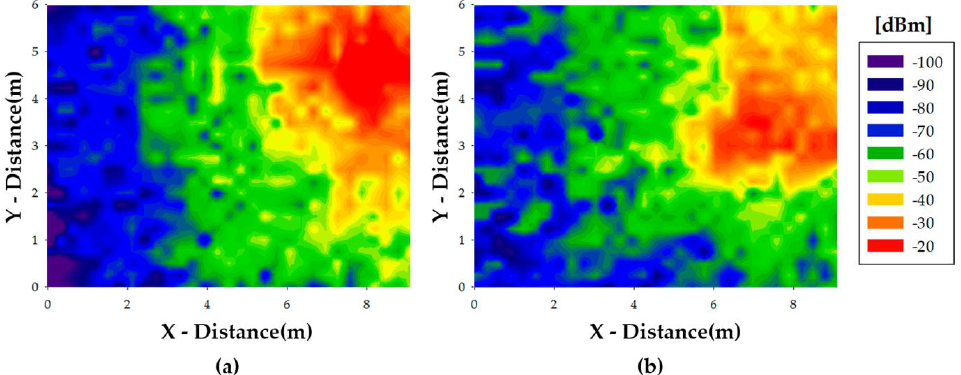
Figure 4. Power distribution in the scenario when transmitter is placed in the living room for an empty living room ( a ) and when the dog is inside the lounge ( b ).